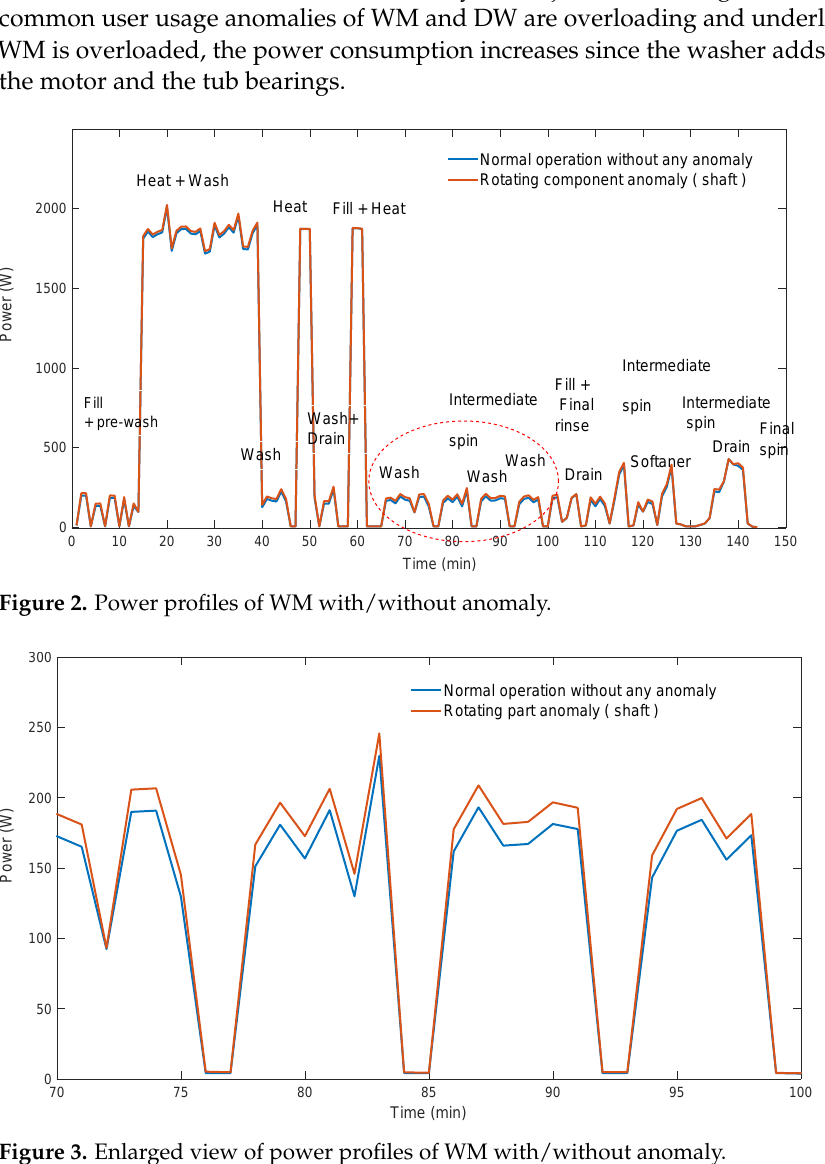
Figure 3. Enlarged view of power profiles of WM with/without